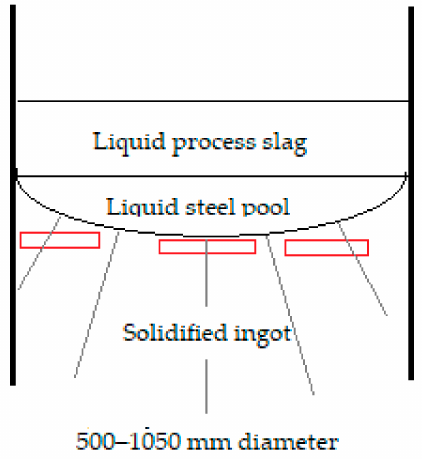
Figure 3. Schematic illustration of the longitudinal sections used for measuring the angle between the dendrites and the axial plane. Four samples were studied from the pressure electro-slag remelted ingots of 500 and 1050 mm diameter (PESR-500 and PESR-1050, respectively) and seven for the pressure electro-slag remelted ingot of 800 mm diameter